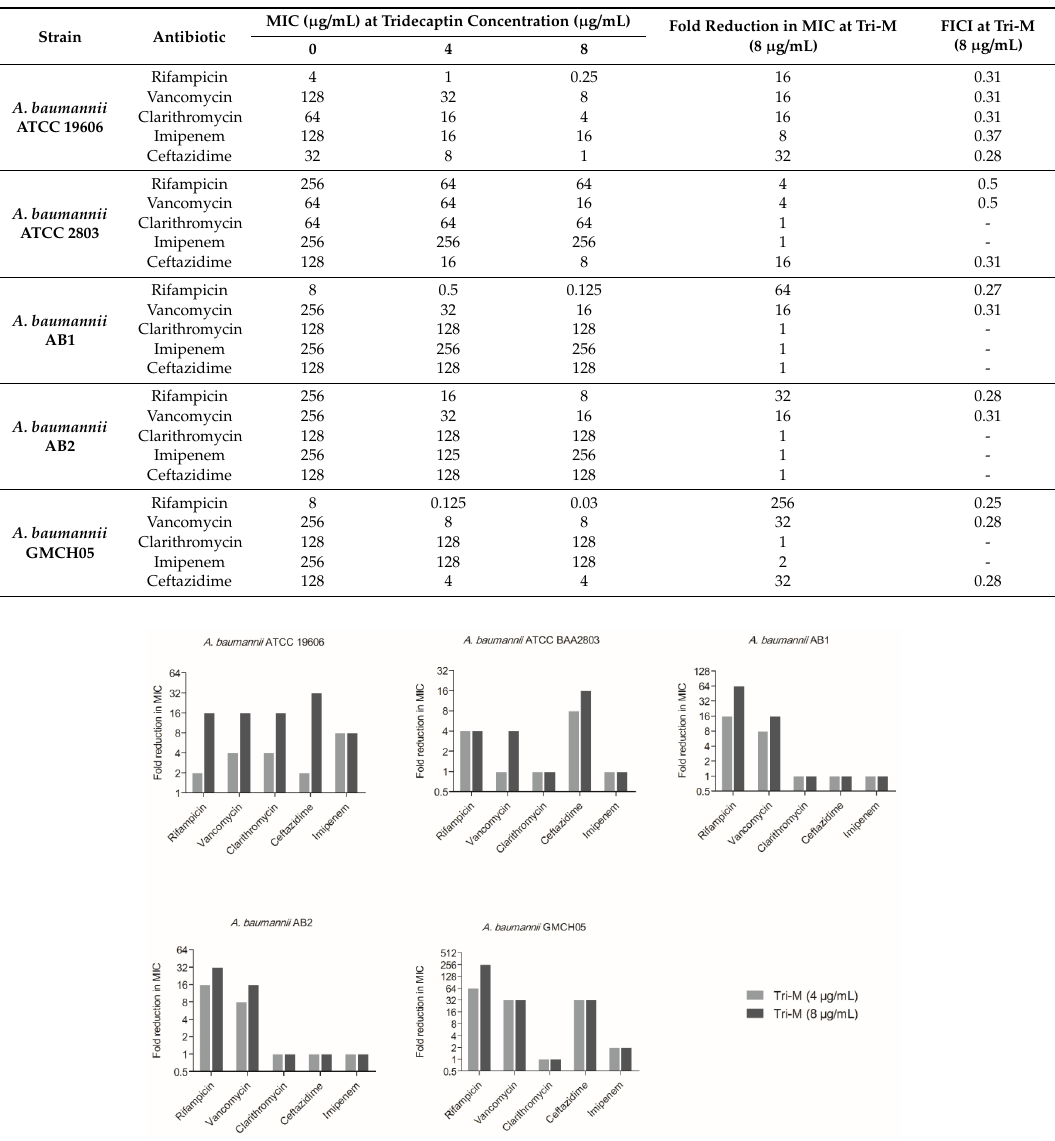
Figure 3. Synergy of tridecaptin M with other antibiotics in A. baumannii strains at two different concentrations. The values presented here are the mode of three independent experiments. 2.3. Tridecaptin M and Rifampicin Combination Shows Efficacy in Rabbit Blood